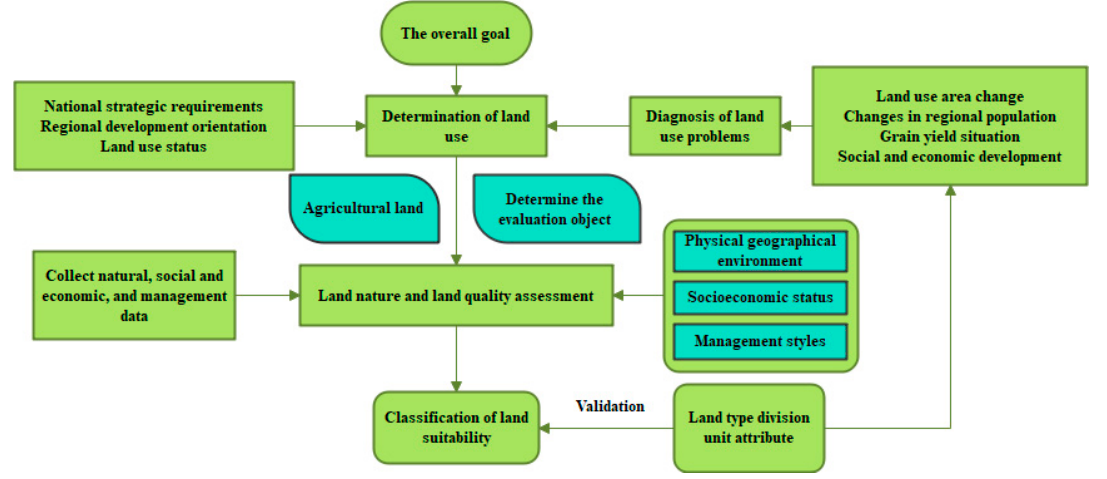
Figure 4. Cultivability evaluation thought map.